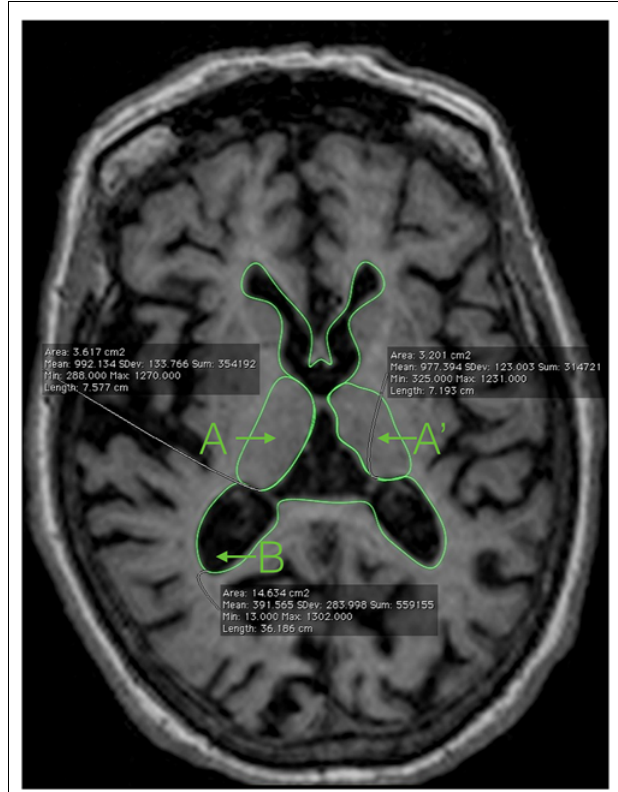
FIGURE 1 | Magnetic resonance imaging showing the areas needed to compute the 2D-yrRTA:A andA’: right and left thalamus; B: ventricular system including the lateral ventricles and the third